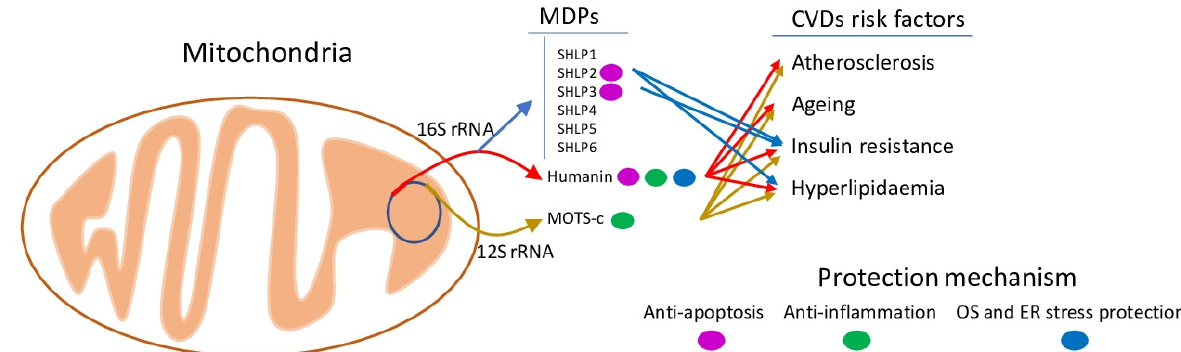
Figure 1. Classification and protection mechanisms of MDPs against CVD risk factors. MDPs (Humanin, SHLPs and MOTS-c) are hidden in mitochondrial 16S and 12S rRNA genes. MDPs are associated with CVD risk factors (atherosclerosis, ageing, insulin resistance and hyperlipidaemia). The main cardioprotective activities identified for MDPs are anti-apoptosis and anti ‐ inflammation, offering protection from OS and ER stresses.